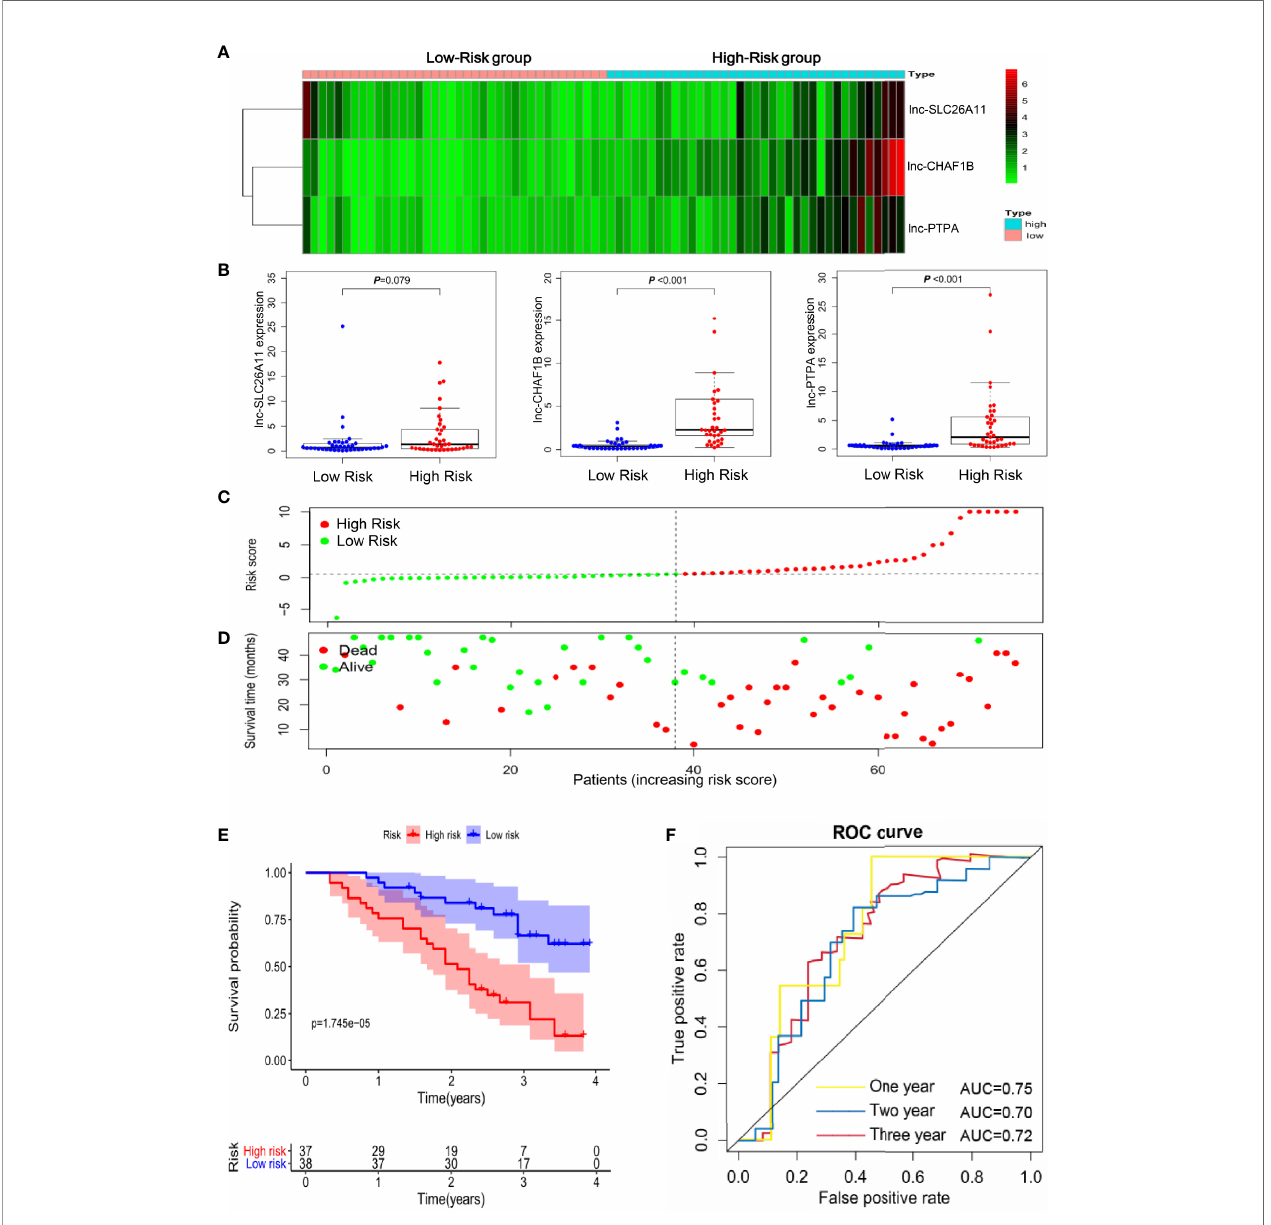
FIGURE 3 | Validation of the immune-related lncRNA signature in an independent gastric cancer cohort. (A) Heatmap of the three-lncRNA panel in 75 validated gastric cancer samples. (B) The expression levels of the three lncRNAs in the 75 gastric cancer samples. (C) Risk score distribution according to the immune-related lncRNA pro fi le in the validated gastric cancer cohort. (D) The association of risk score and survival status in the 75 gastric cancer samples. (E) Kaplan-Meier curves of the overall survival time for high- and low risk patients in the validated gastric cancer cohort. (F) Receiver operating characteristic (ROC) curve analysis showed the area under the receiver-operating curve (AUC) in 1-year, 2-year and 3-year